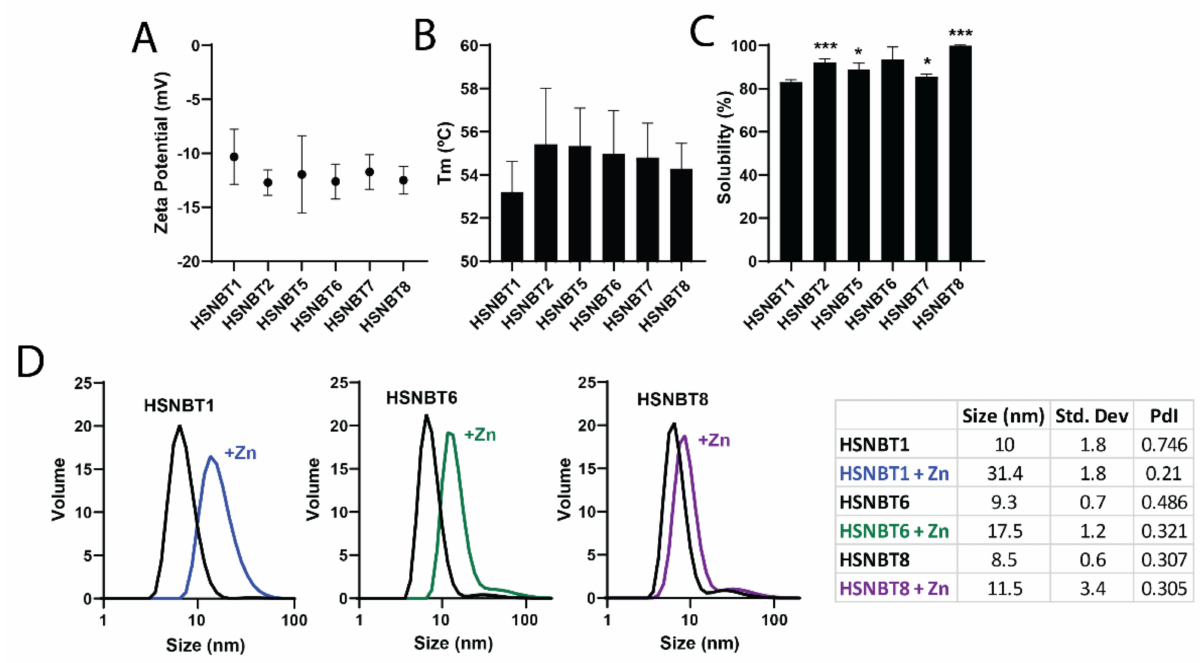
Figure 3. ( A ). Distribution of the zeta potential values measured for the studied proteins. ( B ) Tm of the studied proteins obtained from CSM curves. ( C ) Precipitated portion of each of the protein mutants after the conjugation with the drug MMAE. ( D ) Size-volume profile ( left ) and size data ( right ) of selected candidates measured by DLS before and after nanoparticle formation induced with ZnCl 2 . Significance indicated as: * p ≤ 0.05, *** p ≤